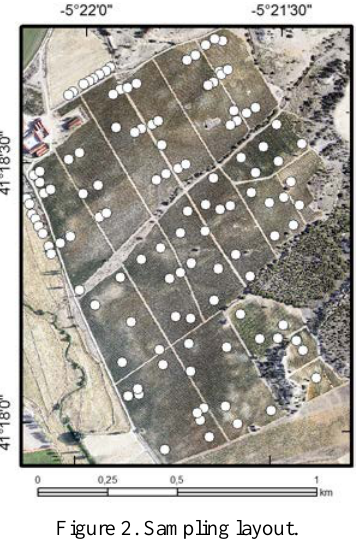
Figure 2. Sampling layout.